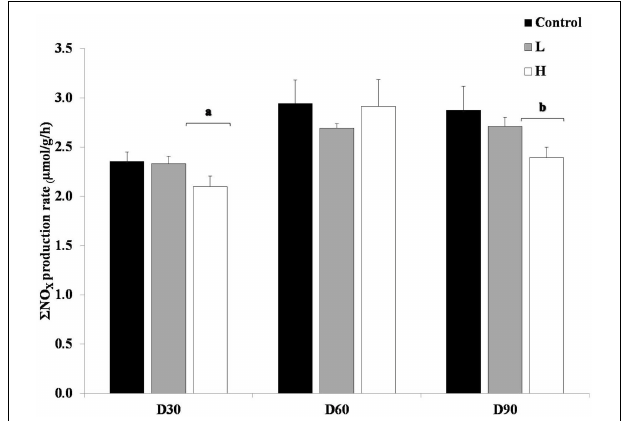
FIGURE 2 | Produced 6 NO X with no re-exposure of PAHs, after 30, 60, and 90 days. The different treatments are shown as C, Control; L, Low; H, High. Values are shown as mean + 1 standard deviation ( n = 5 ). Square brackets with letters (a and b) refers to treatments within a sampling occasion significant different from the other treatment and control (ANOVA).